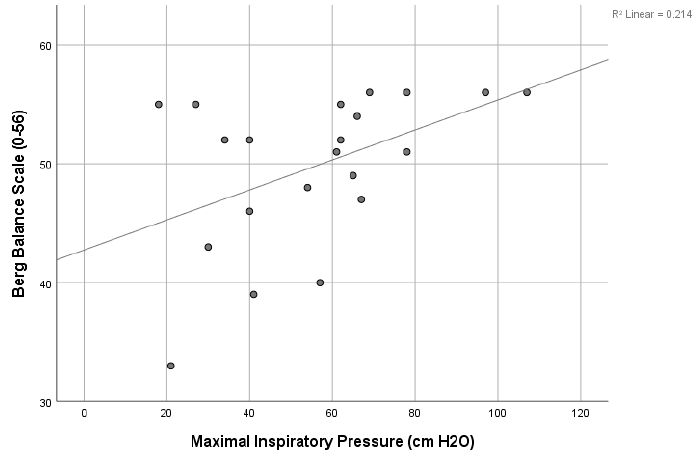
Figure 4. Scatterplot of the relationship between maximal inspiratory pressure and the Berg balance scale.